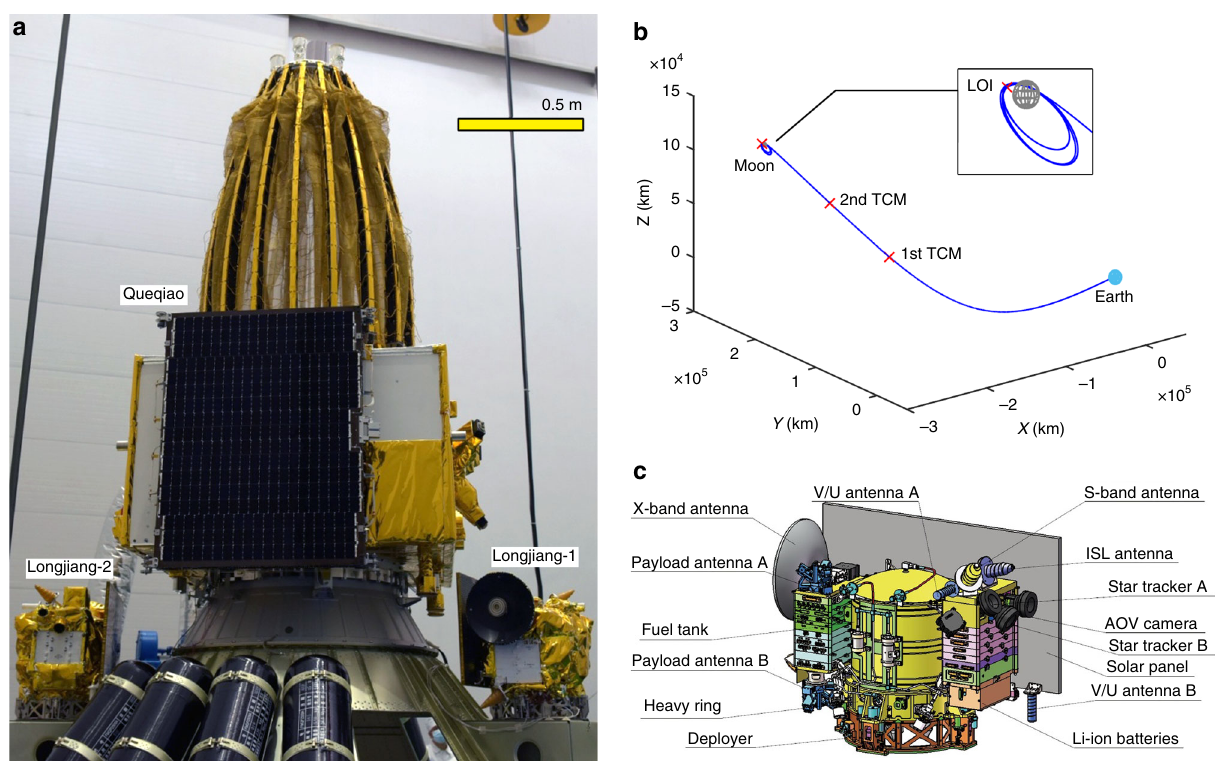
Fig. 1 Longjiang-1/2 satellites. a The Longjiang-1/2 microsatellites and Queqiao relay satellite on the fi nal stage of the launch vehicle. b Orbit of Longjiang- 1/2 from Earth to the Moon in moon- fi xed reference frame. c Equipment arrangement of